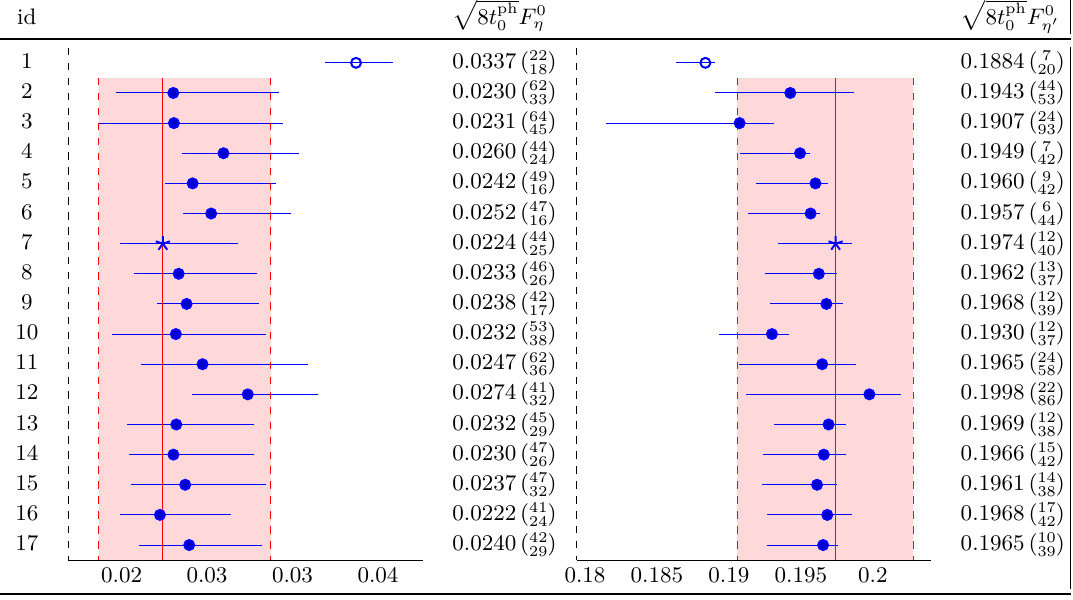
Table 12. Singlet decay constants of the η and η 0 at the physical point in units of the gradient flow scale, displayed as in table 10.